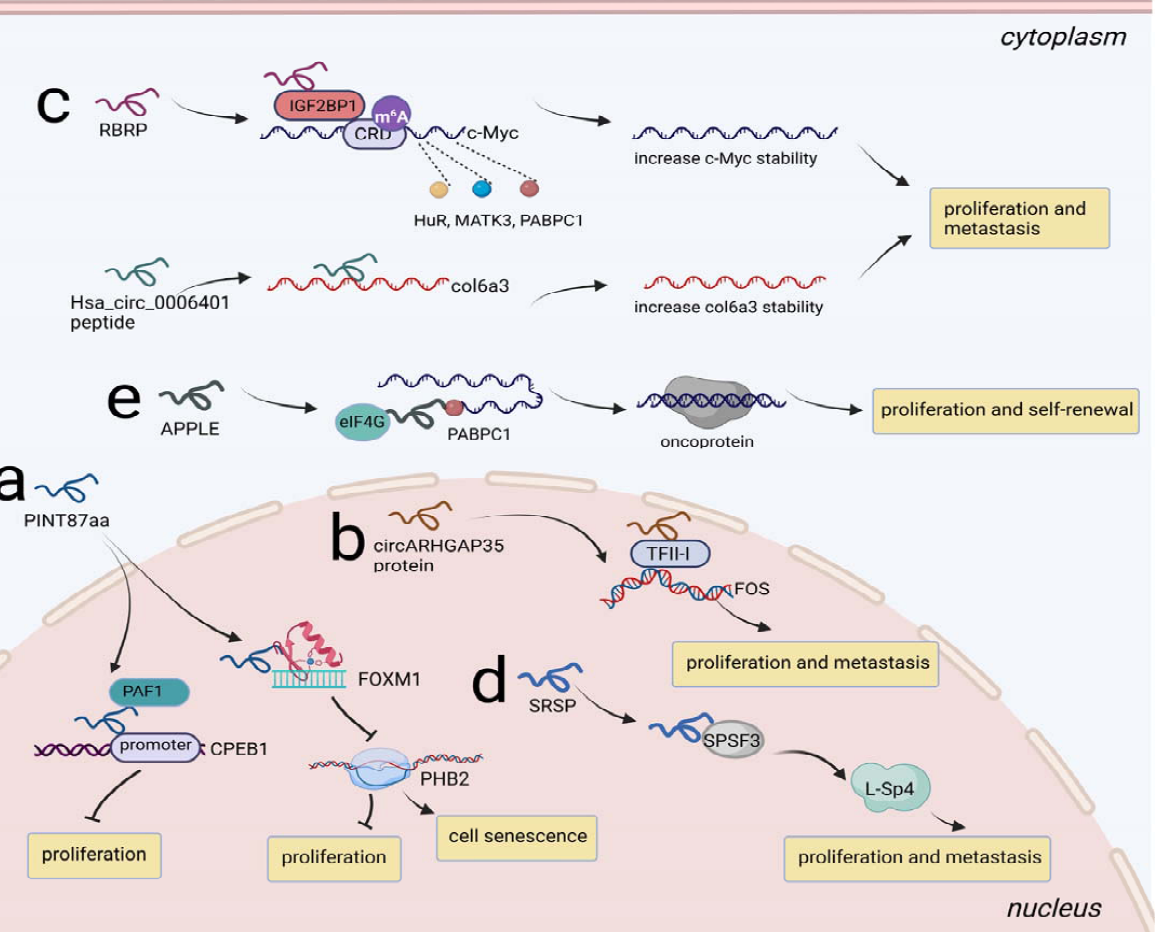
Figure 5. Regulation of NcRNA-encoded peptides/proteins at transcription and posttranscription level. ( a ) PINT87aa bound to FOXM1 to inhibit PHB2 transcription, promoting cell senescence and